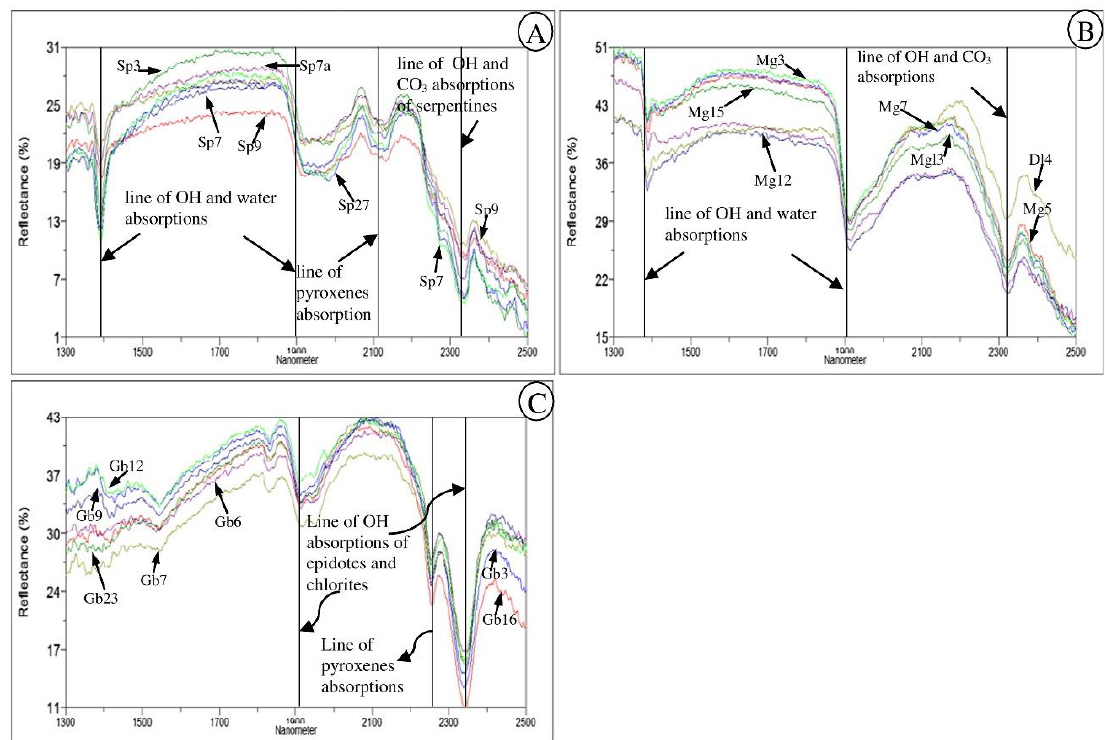
Figure 3. Spectral plots of ( A ) the harzburgites; ( B ) the harzburgites with carbonates; ( C ) the gabbros [25].